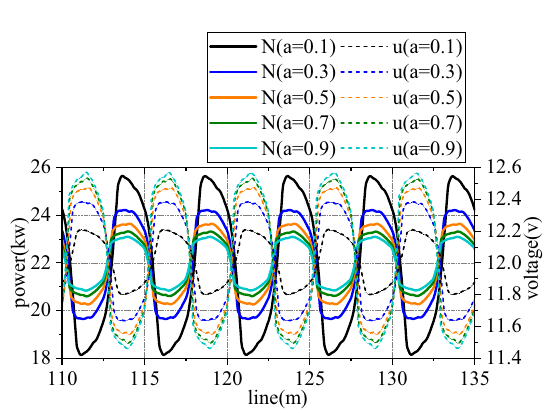
Figure 10. Control parameter and grinding power.